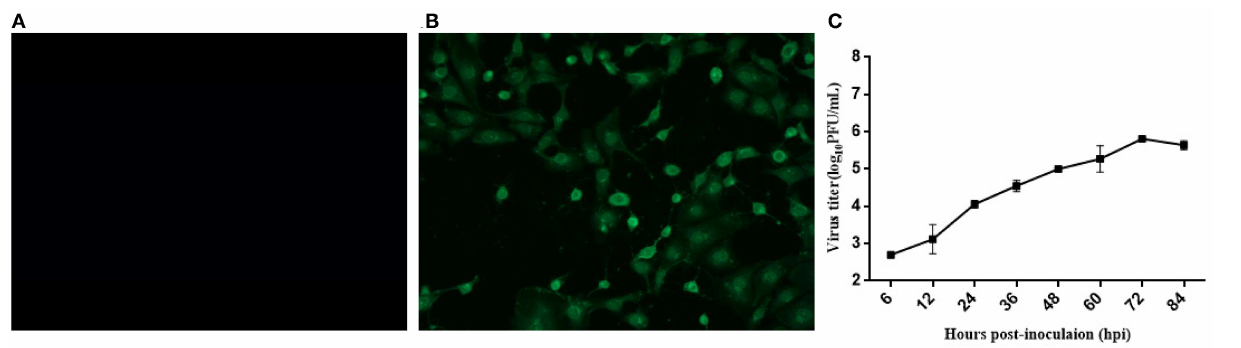
FIGURE 2 | Immunofluorescence assay and growth kinetics of the EV-G CH/17GXQZ/2017 strain in Marc-145 cells. Negative control (A) . IFA staining in Marc-145 cells infected with the EV-G CH/17GXQZ/2017 strain at 48 hpi with mouse anti-EV-G serum (1:100) and Alexa Fluor ® 488 conjugated goat anti-mouse IgG (H + L) (1:4,000) which were used as primary and secondary antibodies, respectively. This shows that the specific green fluorescence was mainly localized in the cytoplasm of infected cells (200 × magnification) (B) . Replication kinetics of the EV-G CH/17GXQZ/2017 strain in Marc-145 cells was determined by plaque assays. Marc-145 cells were inoculated with the EV-G CH/17GXQZ/2017 strain at 0.01 MOI, and the cell culture supernatants were harvested at 6, 12, 24, 36, 48, 60, 72, and 84 hpi, separately. The virus titers are expressed as PFU per milliliter and are shown as the mean values with standard deviations from three replicates (C)